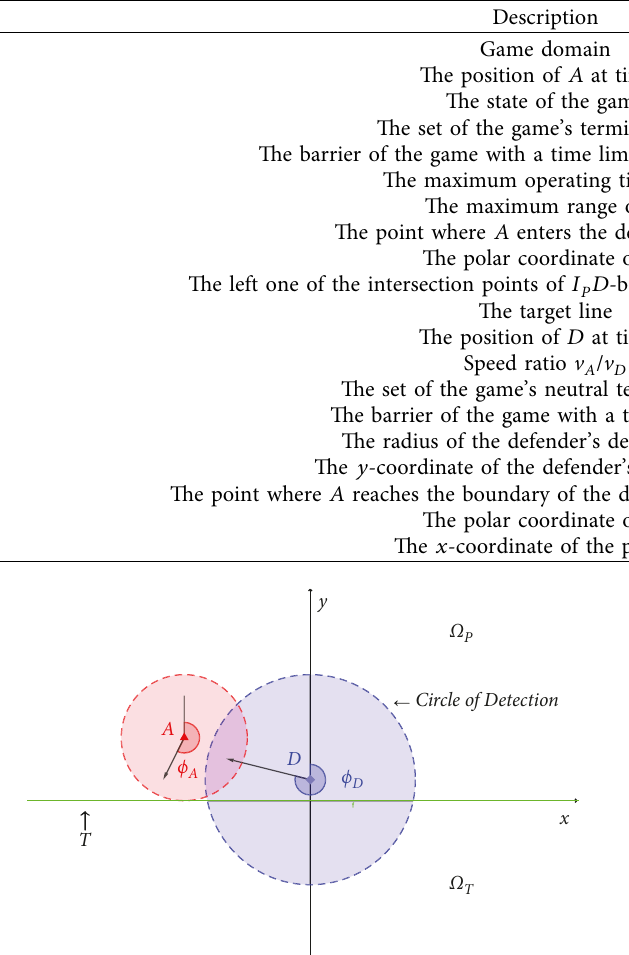
Table 1: Notation table.